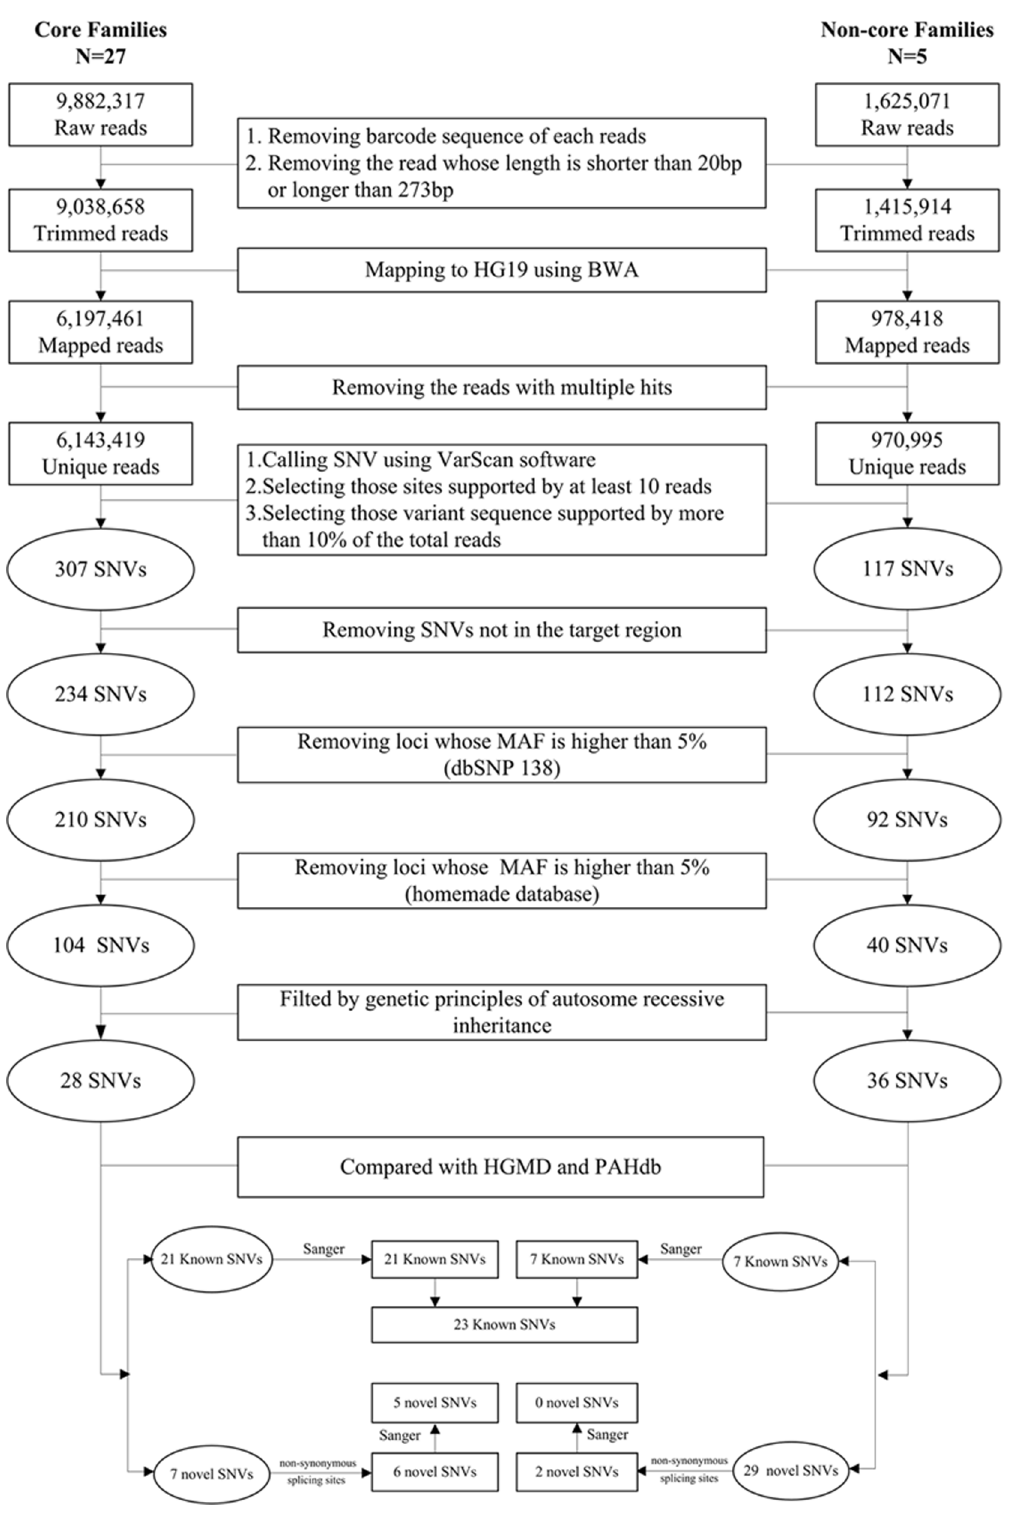
Figure 2. Flowchart for the process of screening and identifying single nucleotide variations (SNVs) in six genes by PGM sequencing.